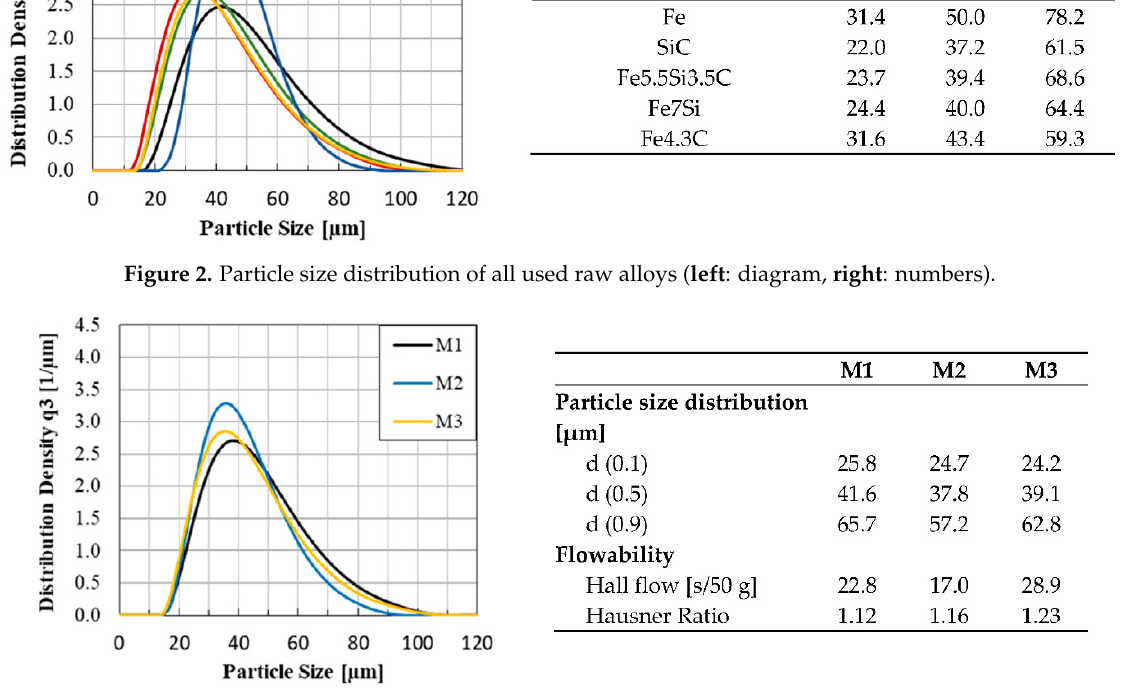
Figure 2. Particle size distribution of all used raw alloys ( left : diagram, right : numbers).